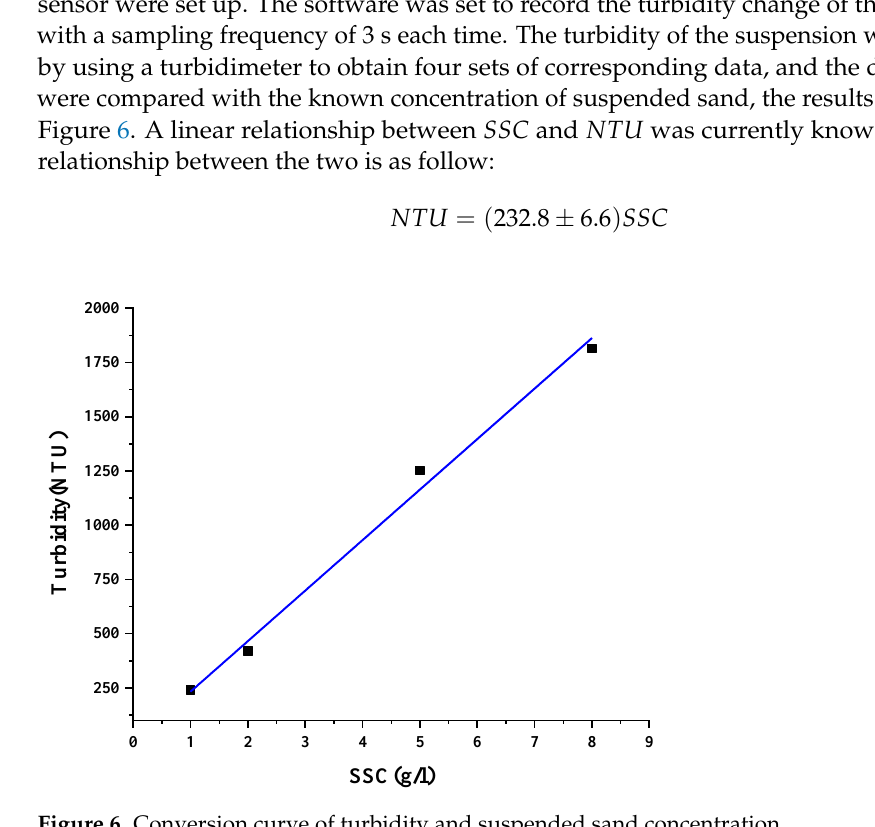
Figure 6. Conversion curve of turbidity and suspended sand concentration.